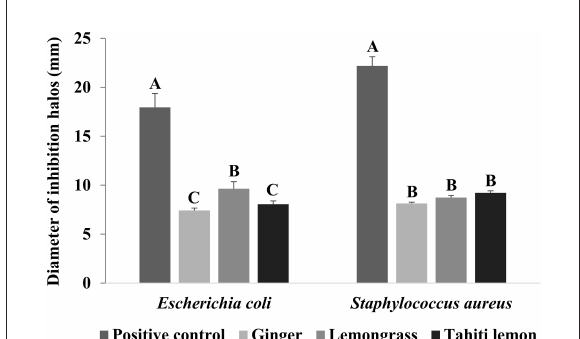
FIGURE1 Antimicrobial action of essential oils (ginger, lemongrass, and Tahiti lemon; concentration 1%) against Escherichia coli and Staphylococcus aureus by the disk diffusion method. (A–C) Means with different uppercase letters differ significantly ( P <